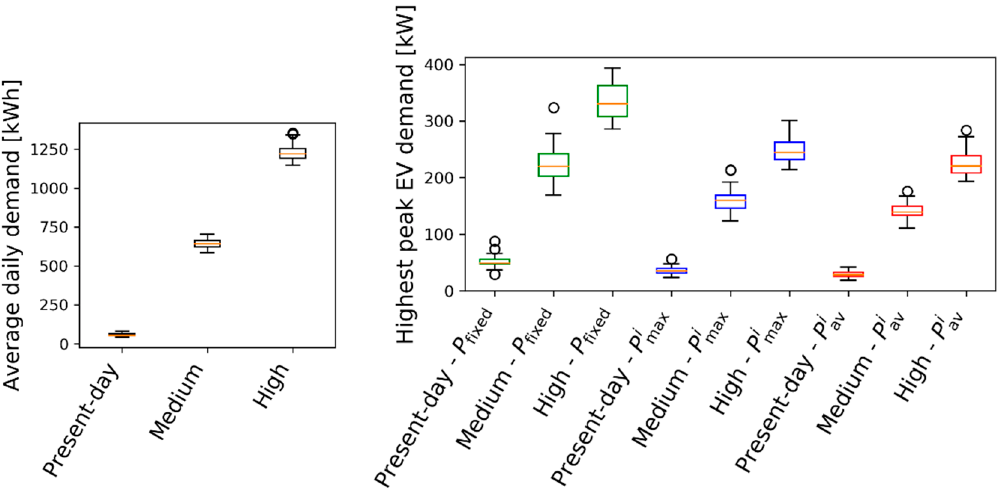
Figure 7. Boxplots of average daily aggregated EV demand ( left ) and highest peak in EV demand ( right ) on the medium voltage (MV)/low voltage (LV)-transformer under study are given. The highest peaks in EV demand are given for the three different charging powers used, showing that peaks are largely overestimated when P fixed is used as EV charging power.